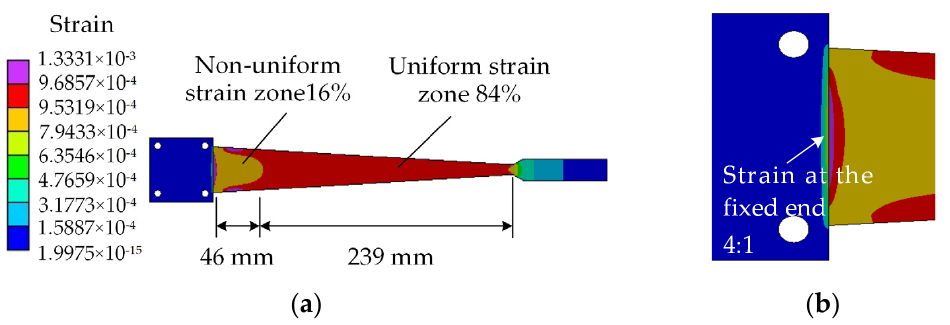
Figure 2. ( a ) Strain distribution on the surface of the beam with a load of 100 N; ( b ) Partial enlarged view of the edge of the fixed end.